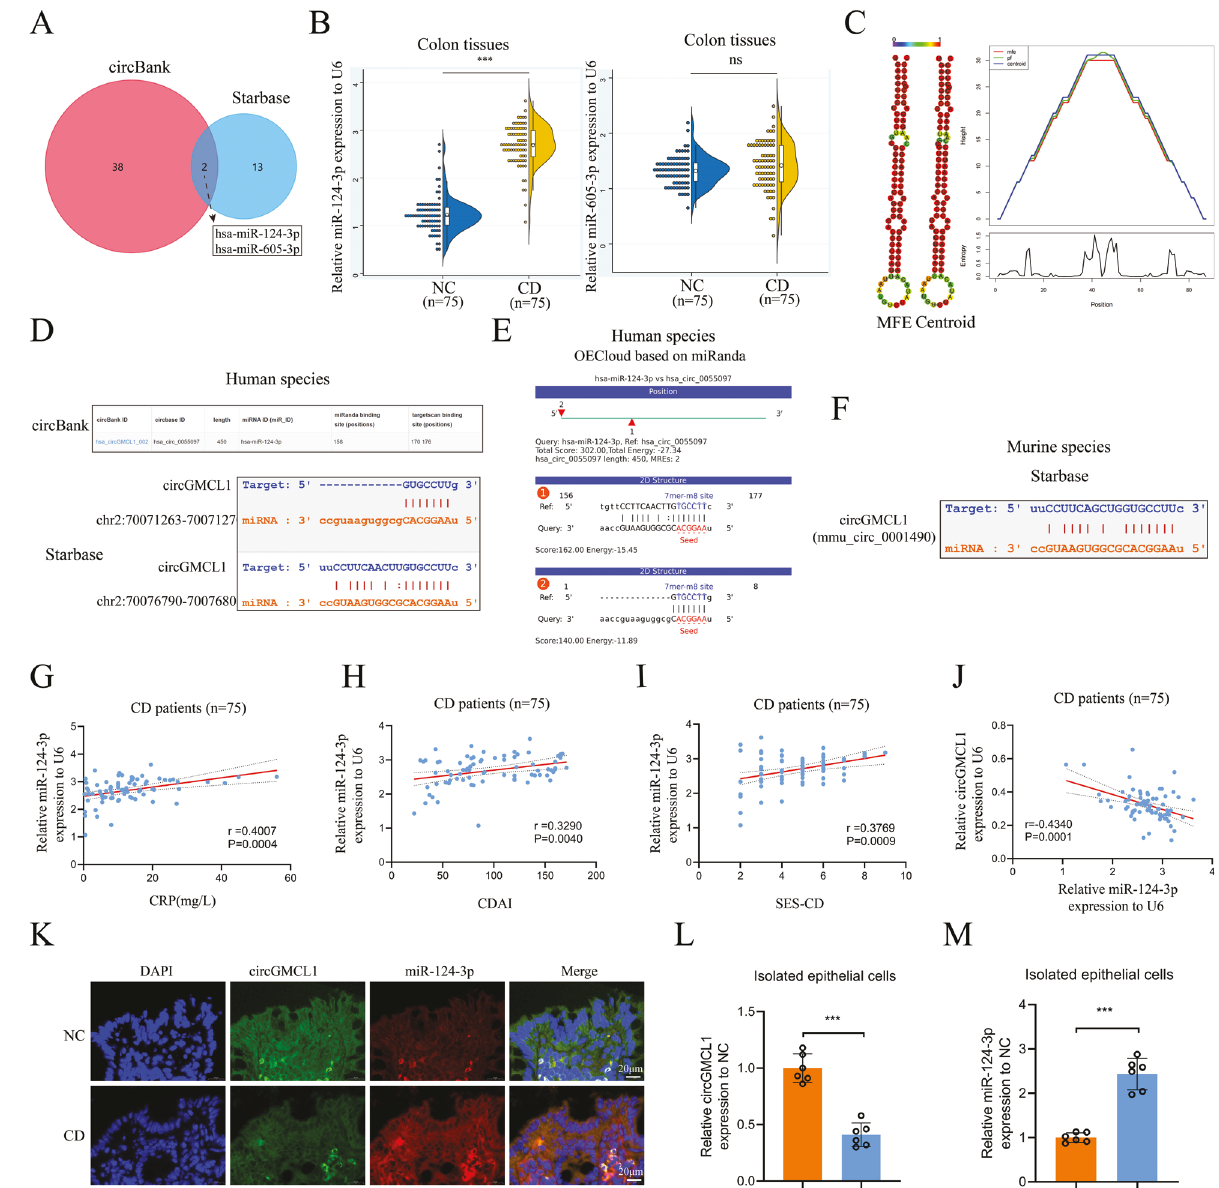
Fig. 2 miR-124-3p was identi fi ed as one target of circGMCL1. A Venn diagram of target miRNAs established by overlapping circBank and starbase databases. B Relative miR-124-3p and miR-605-3p expression of CD patients and NCs was quanti fi ed by qRT-PCR test. C The predicted secondary structures of miR-124. The predicted binding sites between circGMCL1 and miR-124-3p in human species based on starbase and circBank databases ( D ), and OECloud based on miRanda ( E ). F The predicted binding sites between circGMCL1 and miR-124-3p in murine species based on the starbase. The linear correlation between relative miR-124-3p expression and CRP ( G ), CDAI ( H ), SES-CD ( I ), and circGMCL1 expression ( J ) in CD patients ( n = 75) as determined by qRT-PCR test. K FISH analyses of circGMCL1 and miR-124-3p in colon tissues from CD and NCs. The relative expression of circGMCL1 ( L ) and miR-124-3p ( M ) in isolated epithelial cells from CD and NCs. MiRNA, microRNA, CD Crohn ’ s disease, NC normal control, qRT-PCR quantitative real time-polymerase chain reaction, CRP C-reactive protein, CDAI Crohn ’ s disease activity index, SES-CD simple endoscopic score for Crohn ’ s disease, MFE minimum free energy, FISH fl uorescence in situ hybridization, ns, not signi fi cant. Data are expressed as mean ± SD. *** P < 0.001 by Student ’ s t tests. sequence demonstrated the most signi fi cantly inhibitive effec- Veri fi cation of the circGMCL1 ceRNA network tiveness for circGMCL1 expressions (Fig. 4C). The qRT-PCR analysis FISH analysis results indicated that circGMCL1 and miR-124-3p veri fi ed the transfection ef fi cacy of oe- or si-circGMCL1 in NCM460 had consistent cellar localization in NCM460 cells (Fig. 4A). As cells (Fig. 4D). In addition, miR-124-3p expression in NCM460 cells shown in Fig. 4B, the relative luciferase reporter activity co- was signi fi cantly downregulated by oe-circGMCL1, and signi fi - transfected with circGMCL1 WT was signi fi cantly high in miR-124- cantly upregulated by si-circGMCL1 (Fig. 4E). To further explore 3p inhibitor group and low in miR-124-3p mimic group, indicating the interactions between circGMCL1 and miR-124-3p, we per- that circGMCL1 could directly bind to miR-124-3p. Next, we formed Ago2 RIP experiments followed by agarose gel electro- designed and synthesized three si-circGMCL1 sequences targeting phoresis and qRT-PCR analyses. Figure 4F shows that circGMCL1 three different positions. Results showed that the si-circGMCL1 Cell Death and Disease (2022)